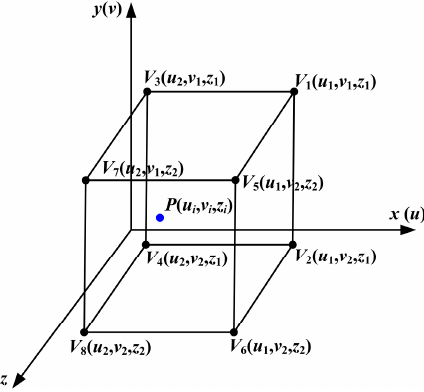
Figure 11. A construction hexahedron enclosing the measured point in the CSEM.